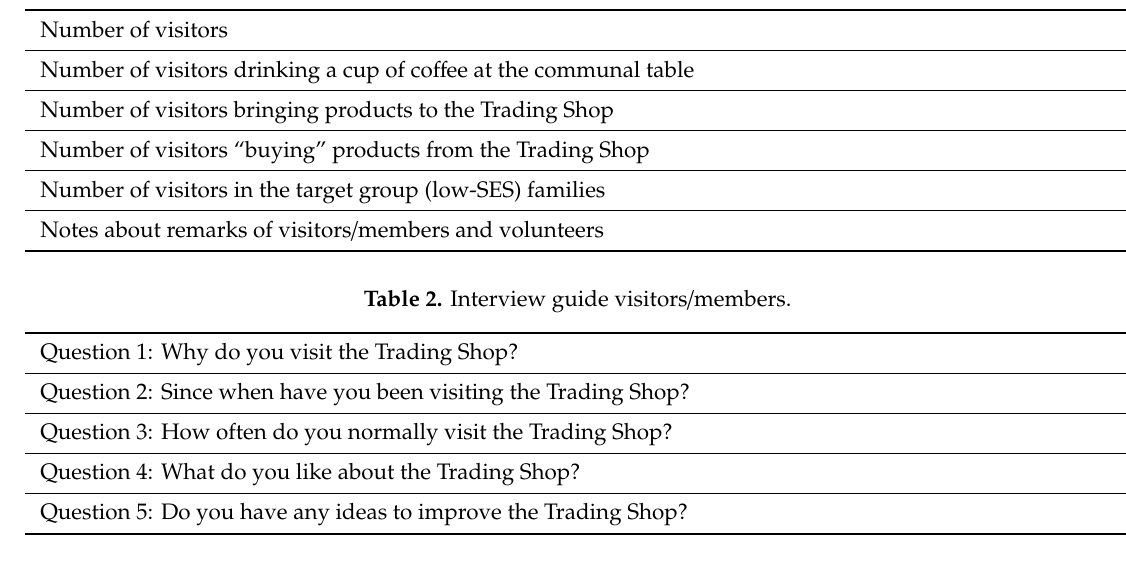
Table 1. Observation list. SES = socioeconomic status.